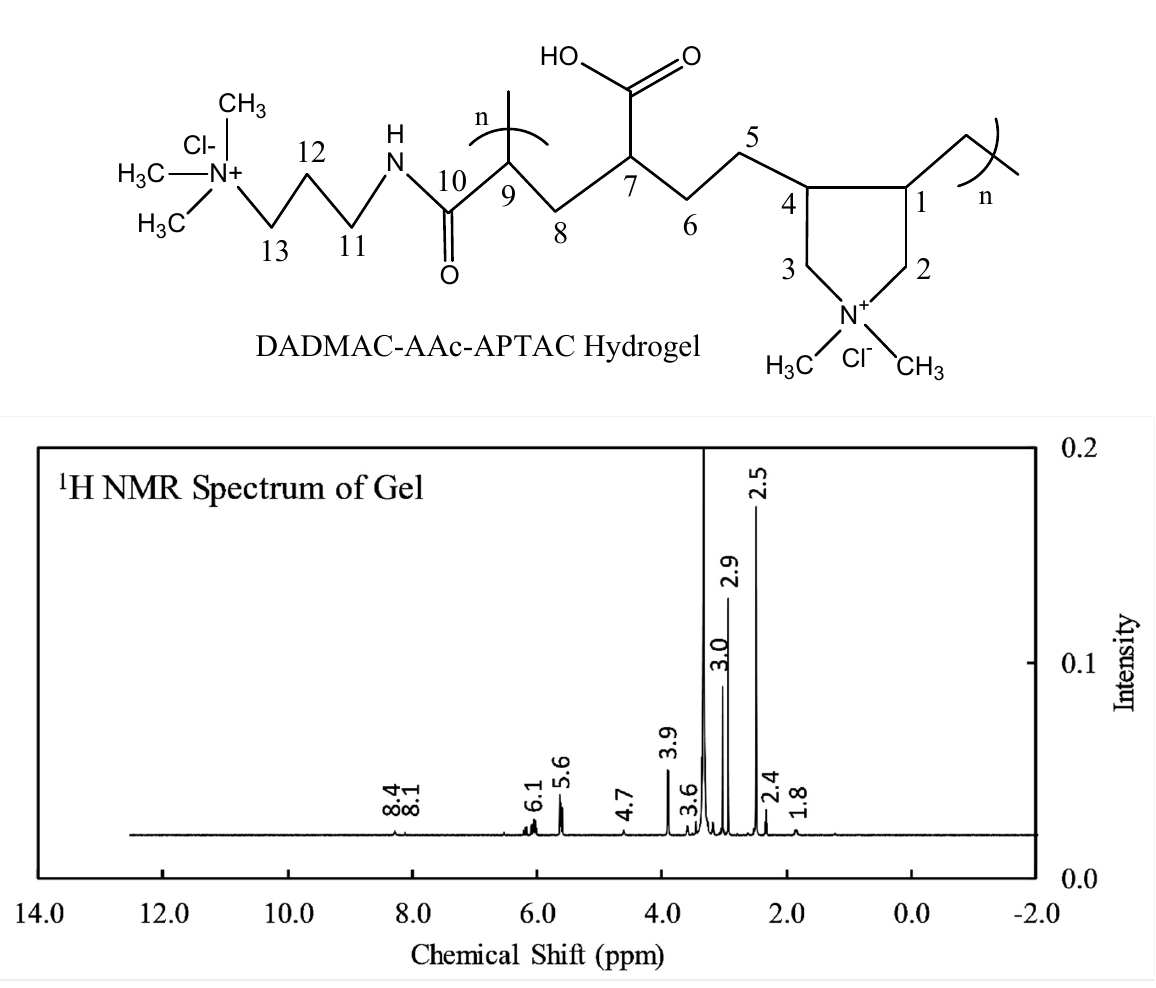
Figure 6. 1 H NMR of DADMAC-AAc-APTAC